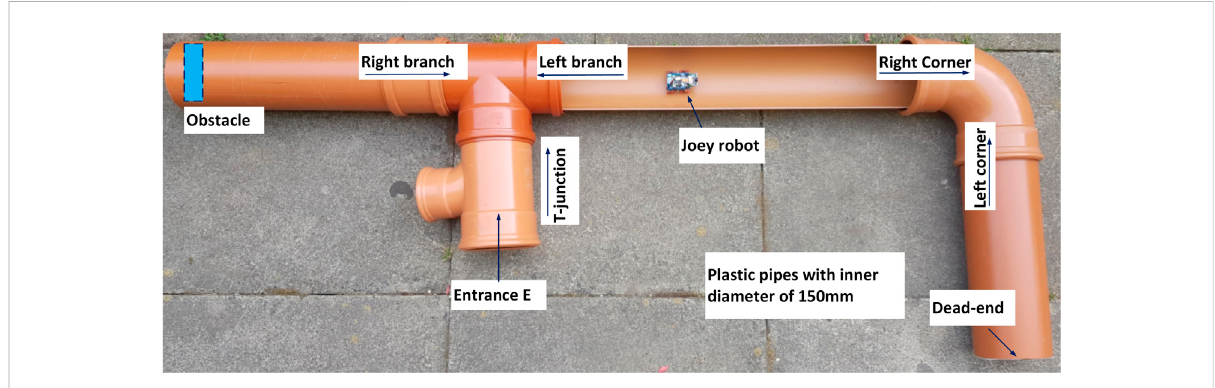
FIGURE 6 Laboratory version of small diameter (150 mm) sewer pipe network. The pipe network was constructed with a T-junction (or left branch, right branch depending on the robot moving direction as showed by the arrows), a left/right corner, a dead-end, an obstacle and three straight pipe sections. One straight section was cut half open for visual